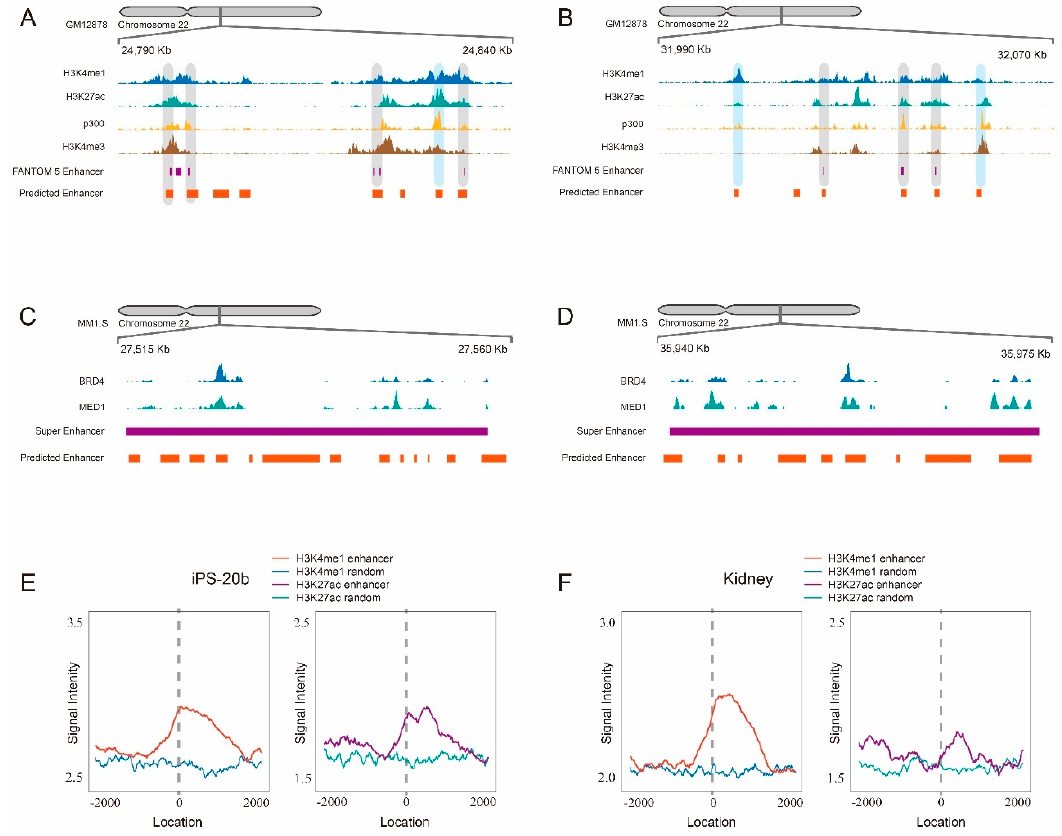
Figure 2. Enhancer-related ENCODE ChIP-seq signals supports the predicted enhancers to be candidate enhancers. ( A ) A representative region within human chromosome 22 for showing that the predicted enhancers have supports either from FANTOM5 enhancer data (shadow regions with gray color) or from ENCODE ChIP-seq signals including H3K4me1, H3K27ac, EP300 and H3K4me3 of GM12878 cell line (shadow regions with blue color); ( B ) Another representative region; ( C ) A case study of a 3.9 kb super-enhancer (chr22:27516134–27555928) which is related to the multiple myeloma in MM1.S cell line;.( D ) Another case study of a 3.1 kb super-enhancer (chr22:35940694–35972007); ( E ) Average signal intensities of two ENCODE ChIP-seq datasets (H3K3me1, red curves and H3K27ac, purple curves) of iPS-20b cell line on the predicted enhancer regions ( ± 2Kbcentered at the predicted enhancers) versus the random genomic regions (blue and green curves); ( F ) A similar demonstration in the adult kidney tissue.